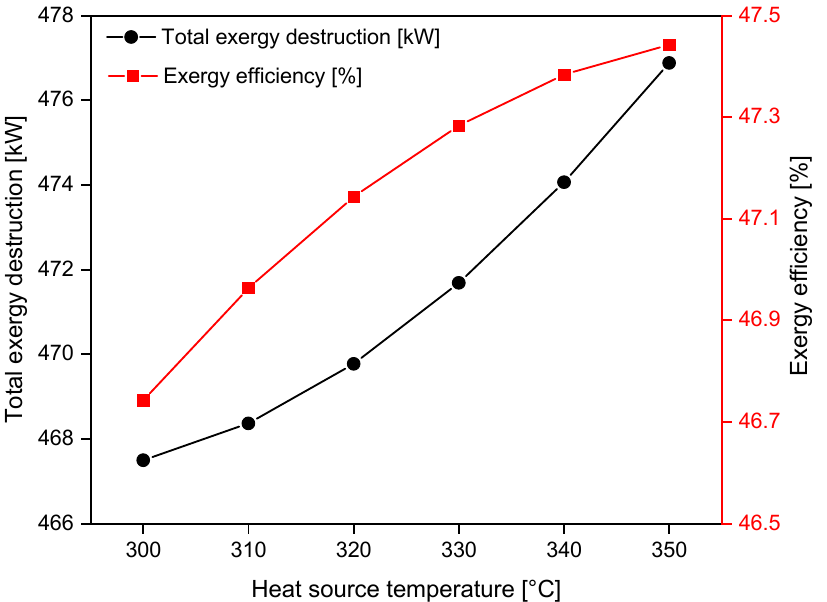
Figure 15. Variation of exergy efficiency and total exergy destruction with heat source temperature in January.